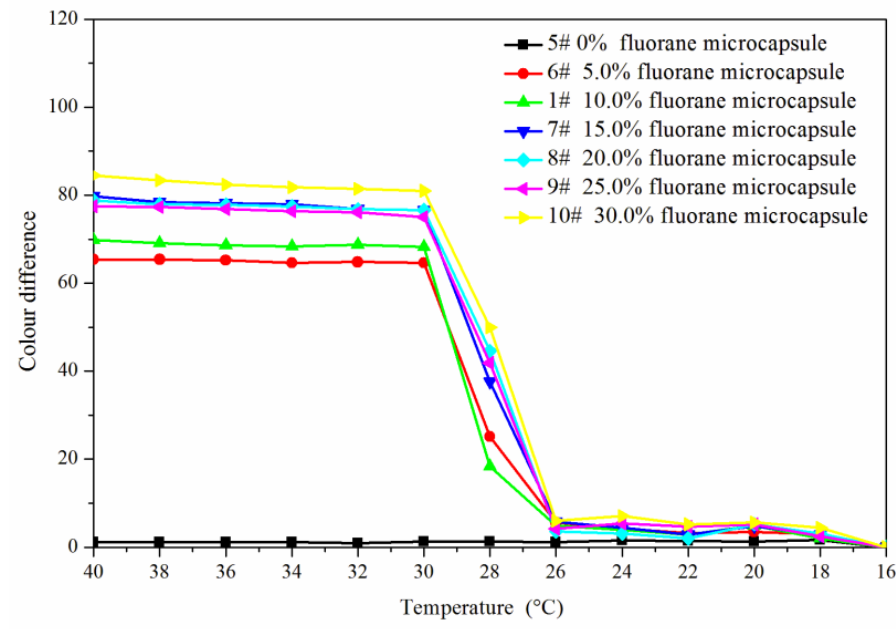
Figure 5. Rising temperature on the color difference of the coating film.